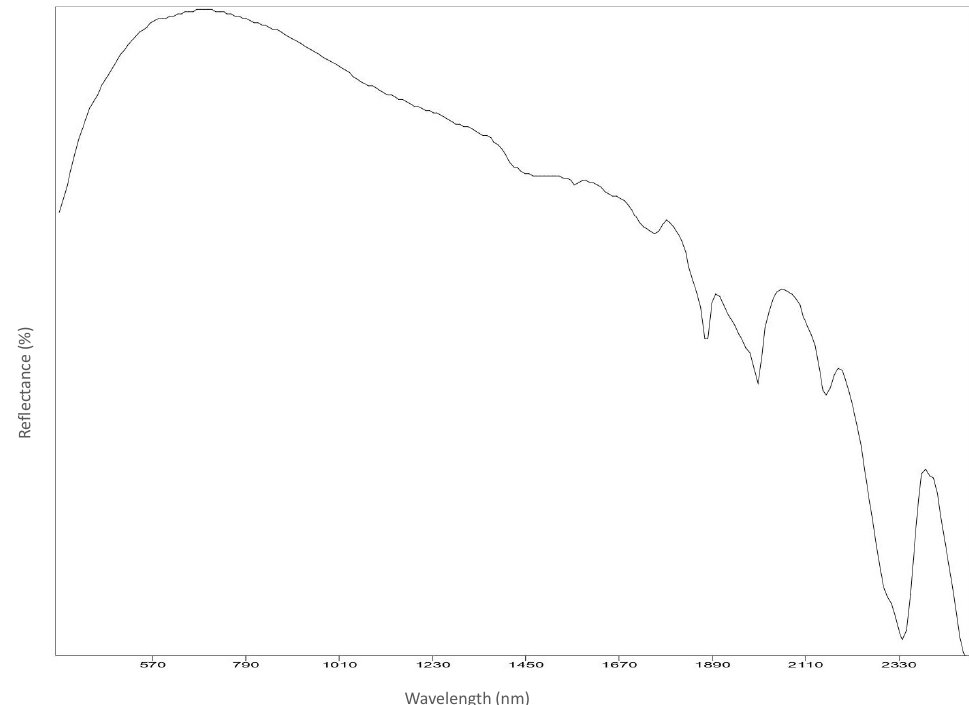
Figure A10. Left shoulder.